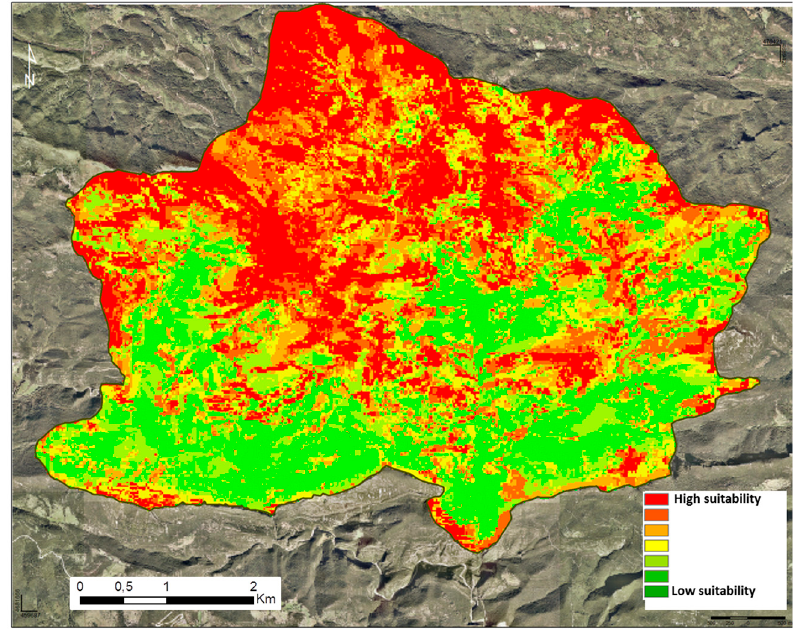
Figure 7. Suitability map according to the management matrix (Scenario 3).